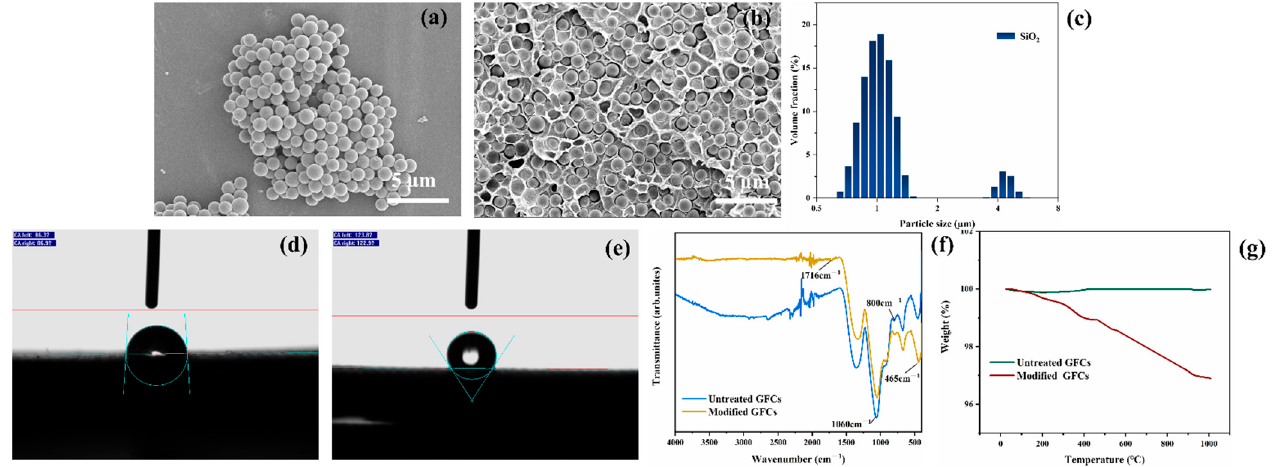
Figure 2. ( a ) SEM image of the spherical SiO 2 powder; ( b ) cross ‐ sectional micrograph showing neat polyolefin filling with 40 wt% SiO 2 ; ( c ) particle distribution of SiO 2 ; contact angle of water drop on ( d ) untreated GFCs and ( e ) modified GFCs; ( f ) FTIR spectra of untreated and modified GFCs; ( g ) TGA thermograms of untreated and modified GFCs.